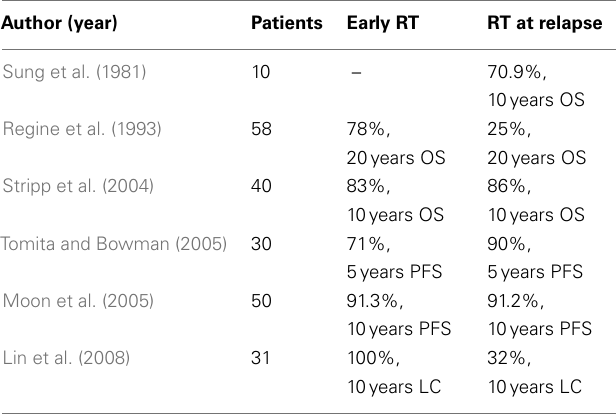
Table 3 | Early versus delayed radiation therapy/impact on progression-free and overall